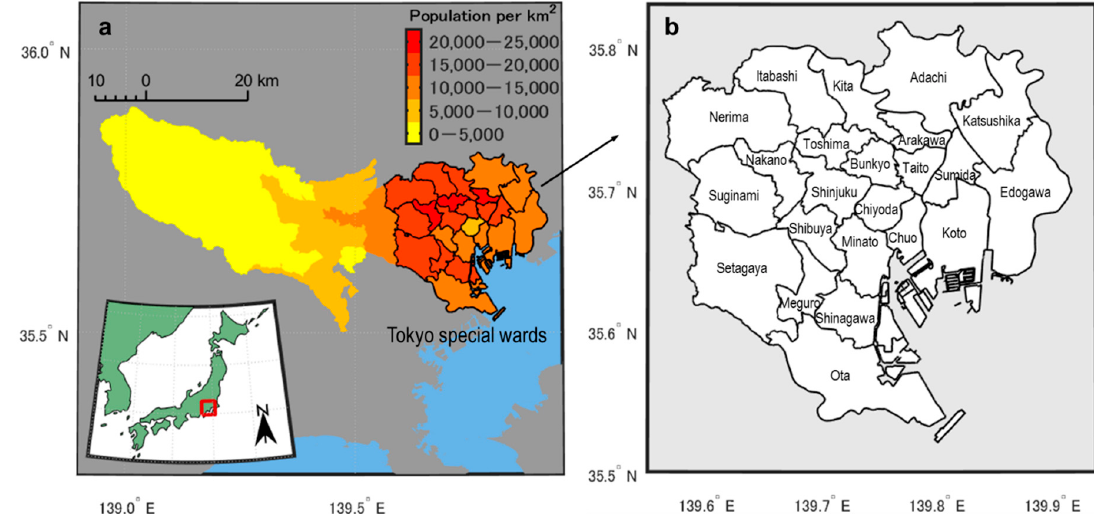
Figure 1. ( a ) Study area superimposed on the population density map of Tokyo according to the 2015 National Population Census. The area surrounded by the black lines with high population density indicates our study area of 23 municipalities (Tokyo special wards). ( b ) Location and name of each municipality (special ward). The maps were generated using MATLAB R2018b.